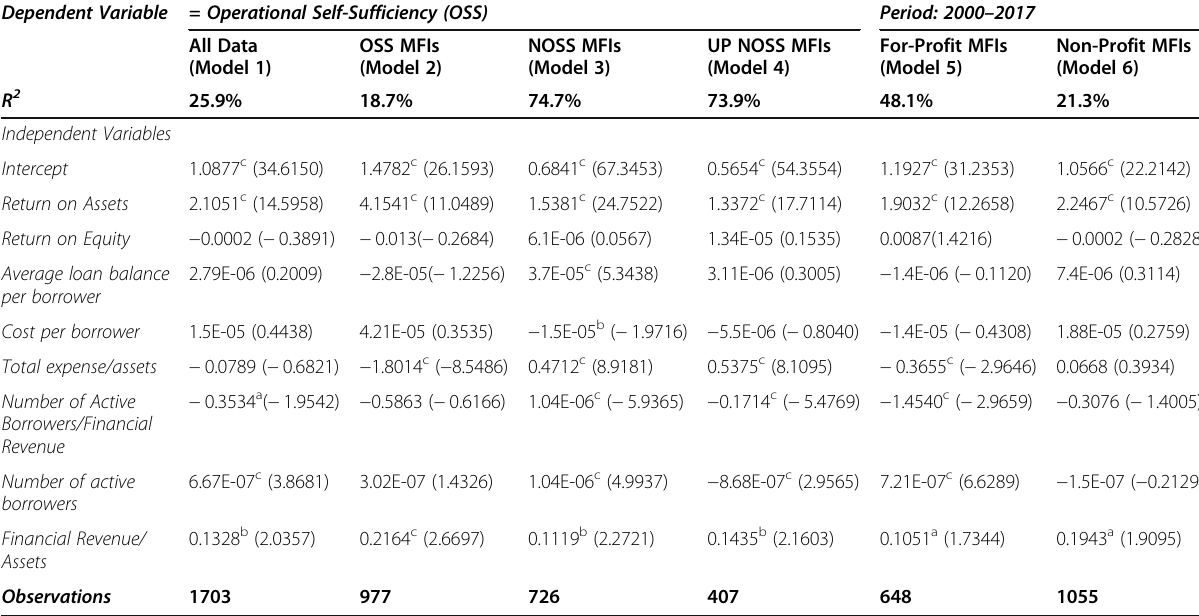
Table 4 Regression Analysis Dependent Variable = Operational Self-Sufficiency